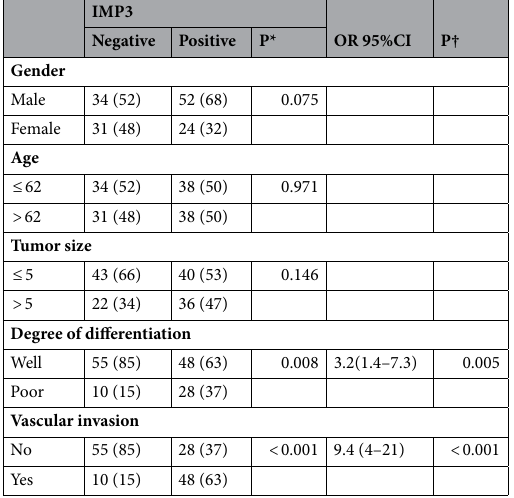
Table 2. The number (%) of patients according to the examined variables and logistic regression results in relation to IMP3. * χ 2test; † Logistic regression.